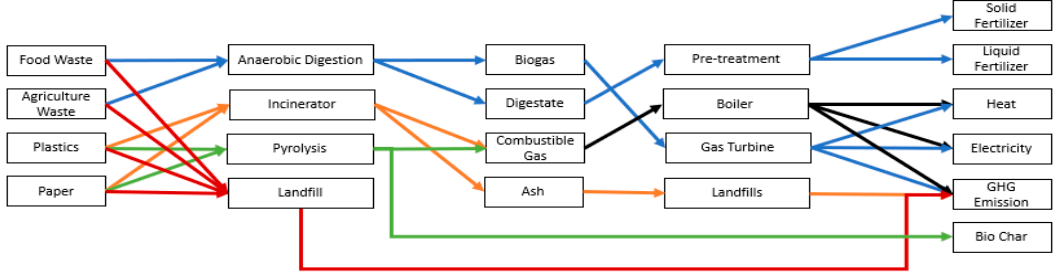
Figure 3. Superstructure for process flow managing MSW in this case study.